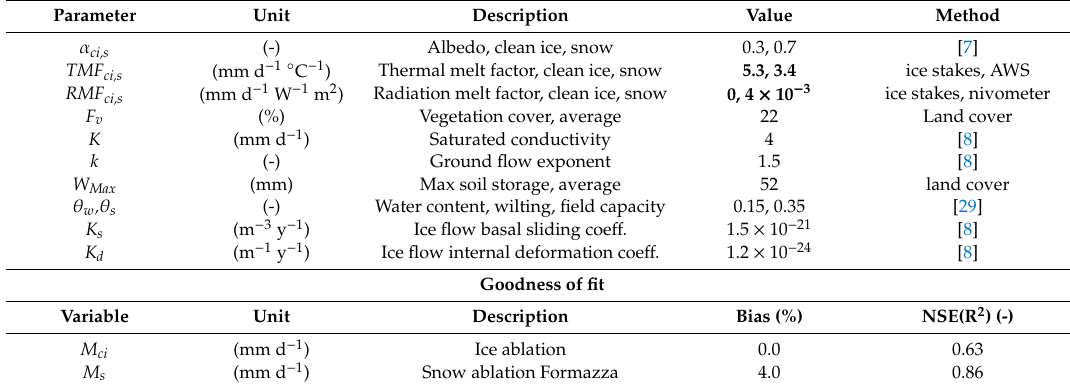
Figure 3. Sabbione glacier. Simulated and observed ice covered area ICA, and estimated ice thickness in years 2007 ( a ), 2012 ( b ), 2015 ( c ), 2017 ( d ). Table 4. Glacio-hydrological model parameters, and goodness of fit statistics. Thermal melt factor and radiation melt factor are both reported for ice and snow. Bold values are calibrated against observed values.